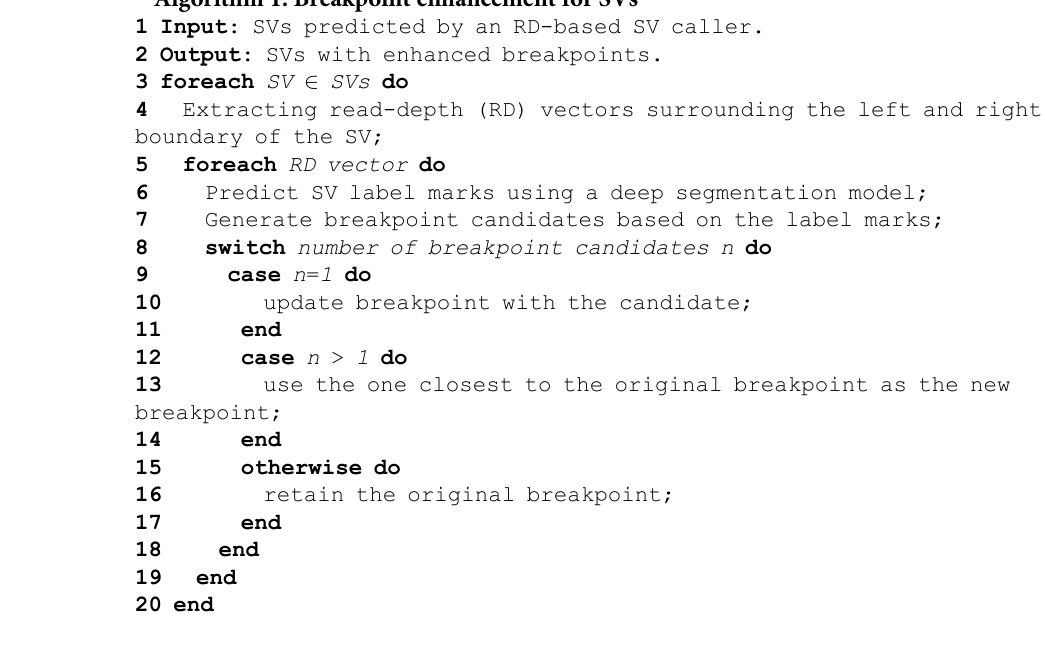
Algorithm 1: Breakpoint enhancement for